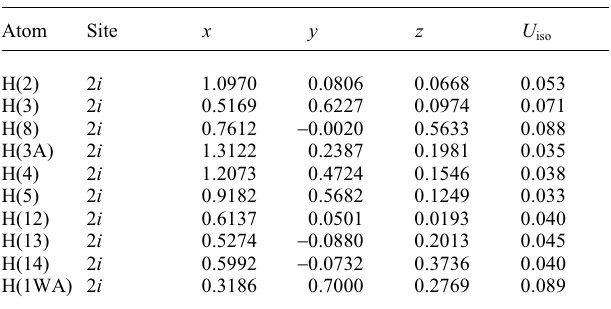
Table 2. Atomic coordinates and displacement parameters (in Å 2 )